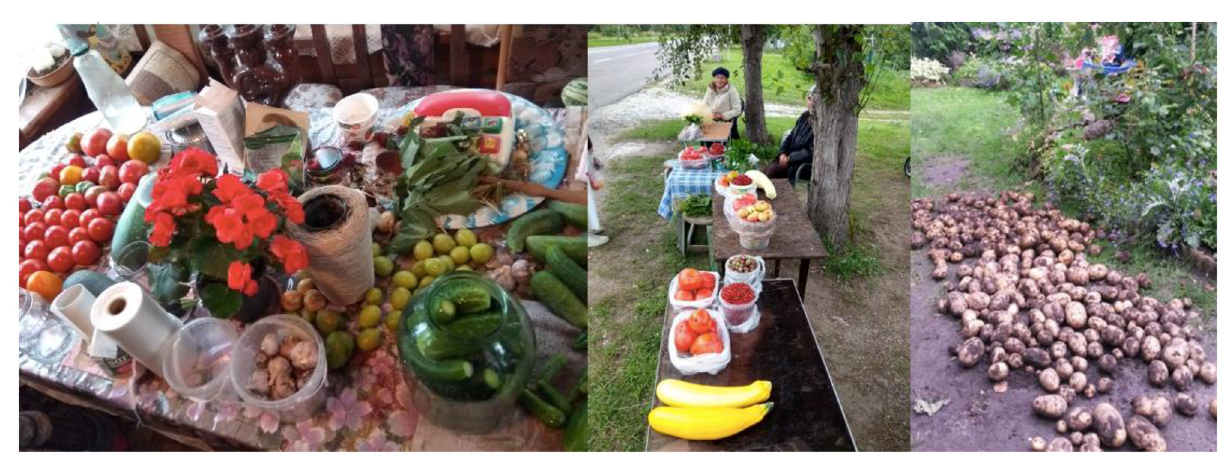
FIGURE5 The photo on the left shows a rather large-scale preparing of pickled vegetables by an elderly couple on their dacha; the middle photo two women selling their garden produce at the street between Narva and Narva-Jõesuu to earn some extra money; the photo on the right shows a potato harvest at a dacha garden in autumn (photo by the